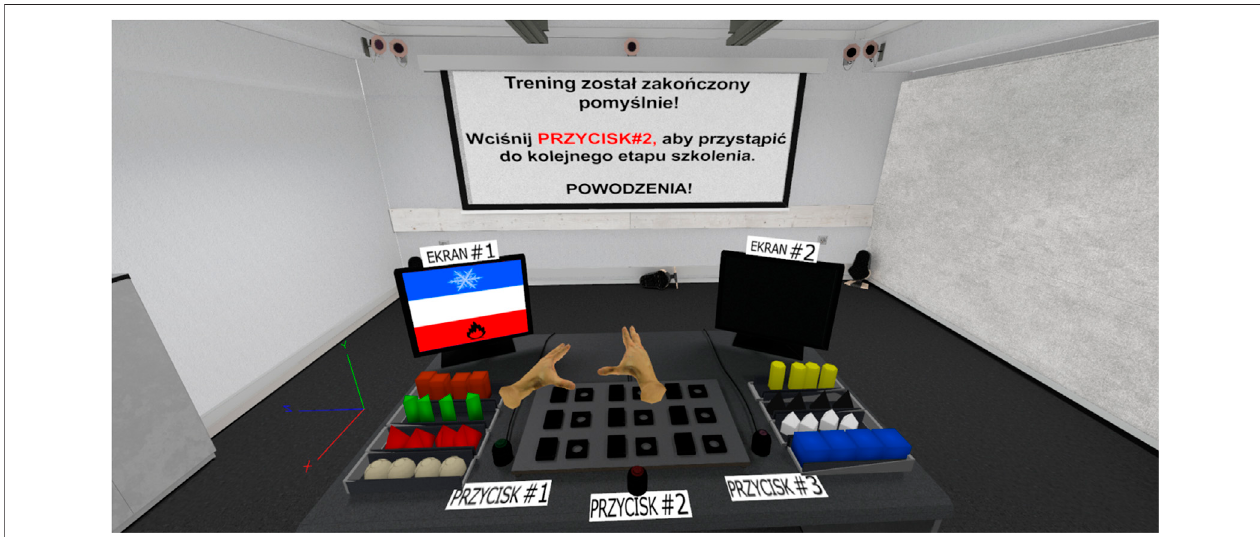
FIGURE 2 | Virtual training environment. The elements of the workstation are labeled. Hand avatars are visible in the foreground.